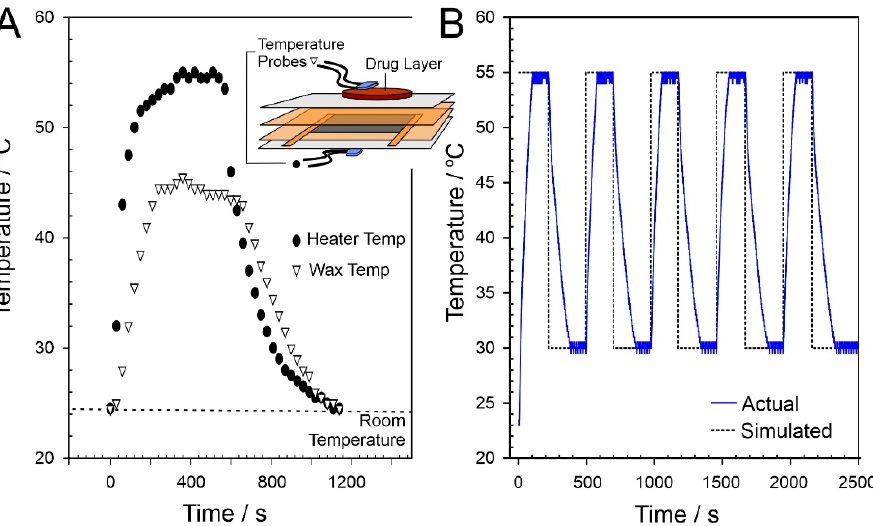
Figure 6. ( A ) Variation in measured temperature at the heater (circles) and drug–solution (triangles) interfaces. Inset: experimental configuration used to acquire temperature data. ( B ) Comparison of simulated and actual temperature profile at the LIG heater upon repetitive cycling.